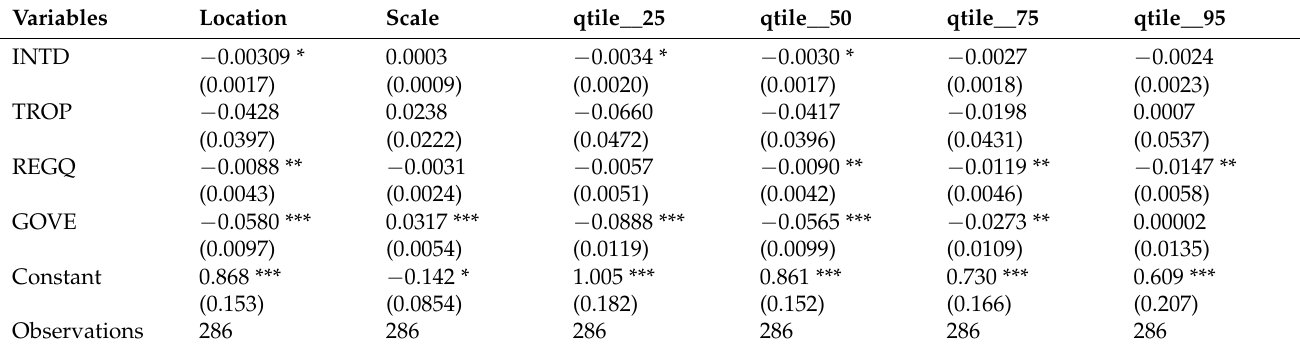
Table 7. Model 5. DV: Income Inequality Gini Coefficient (INGN).